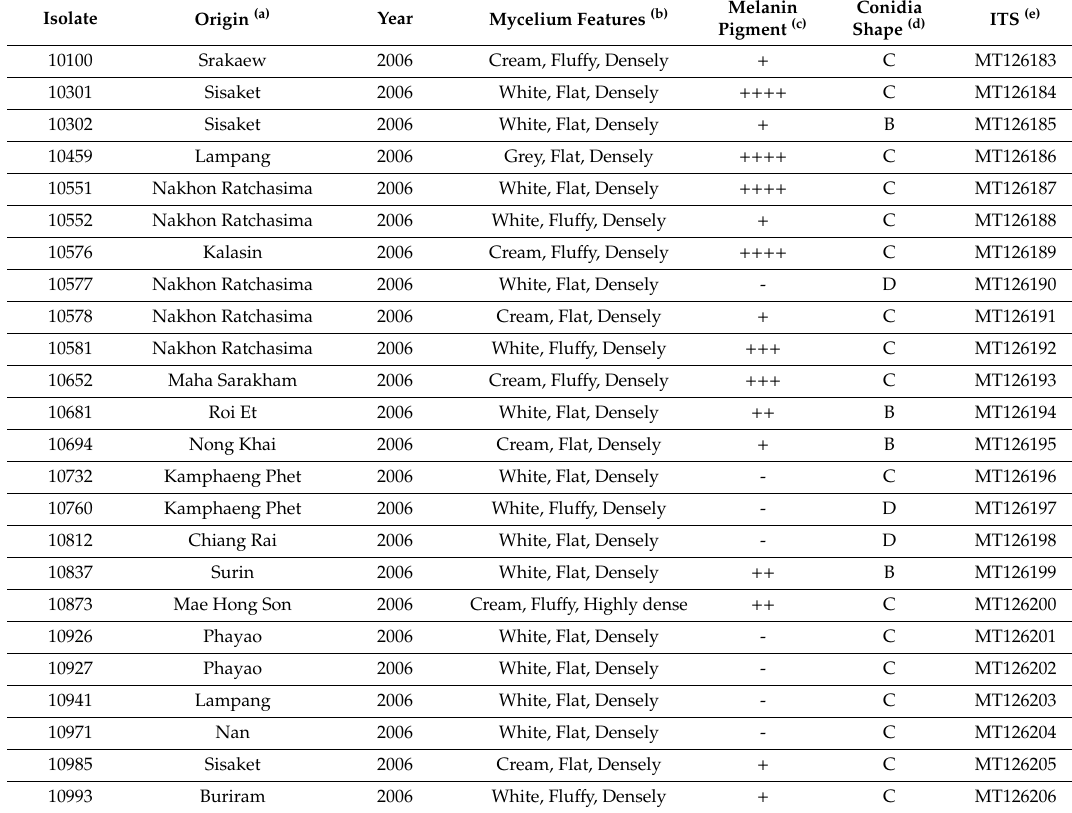
Table 1. Fungal morphological characteristics of 59 rice blast strains and their internal transcribed spacer (ITS)